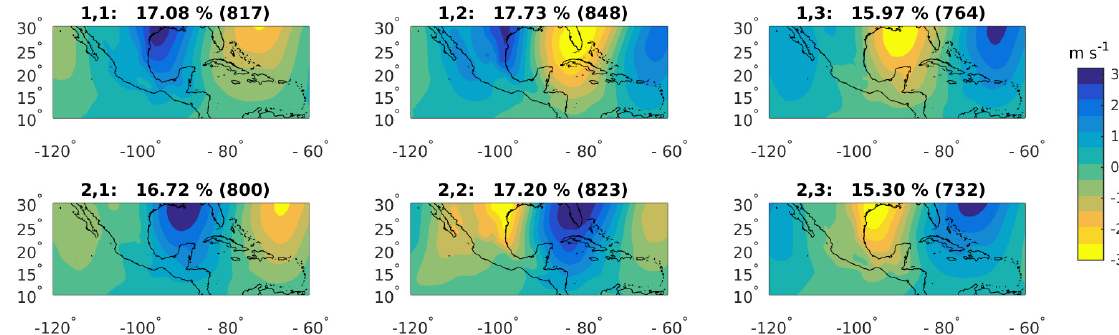
Figure 5. Same as Figure 2, but for component v of wind at 700